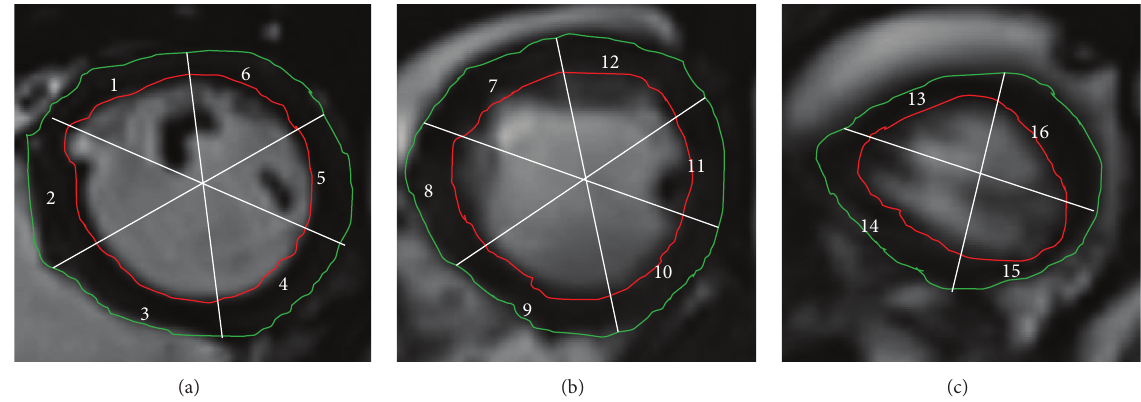
Figure 1: Segmentation example in a normal case showing (a) basal, (b) midventricular, and (c) apical